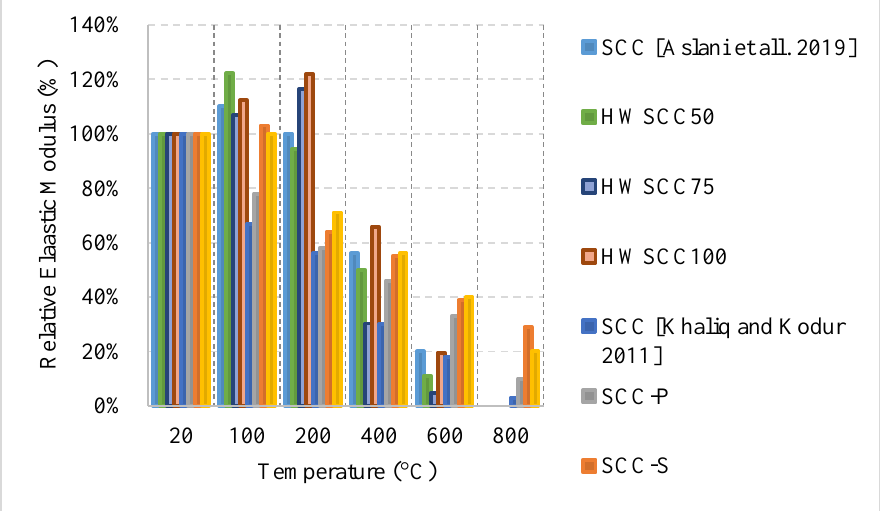
Figure 45. Relative Elastic modulus of different naturally cooled SCC mixes. S = Steel fibers, P = PP fibers, H = Hybrid, 50, 75, and 100 = Heavyweight magnetite aggregate with 50%, 75%, and 100% replacement ratio [75,108].